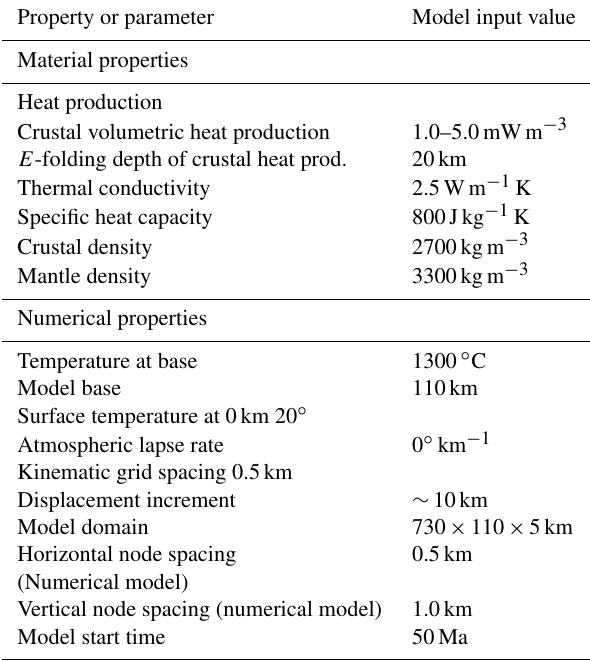
Table 2. Thermal and rock property parameters assigned as input for